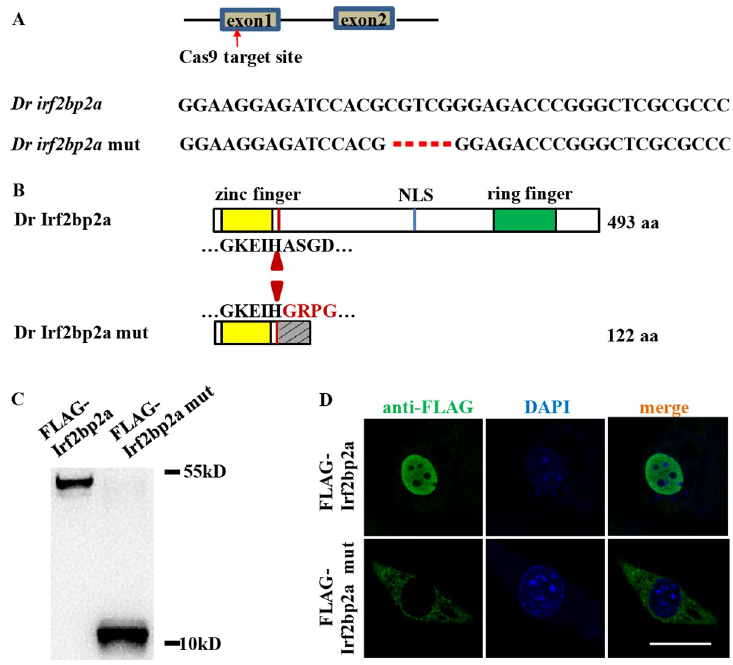
Fig 1. The establishment of a zebrafish irf2bp2a knockout line. (A) Schematic representation of Cas9 target site in the first exon of zebrafish irf2bp2a . The deleted nucleotides in the mutant gene are marked by hyphens. (B) Schematic representation of wild type (493 amino acids) and mutant Irf2bp2a proteins (122 amino acids). The site where the frameshift was introduced is marked by triangles. (C) Western blot analysis of FLAG-tagged wild type and mutant Irf2bp2a proteins expressed in HEK293 cells. (D) Immunofluorescence analysis of FLAG-tagged wild type (top panel) and mutant Irf2bp2a (bottom panel) proteins, demonstrating that the truncated protein lost its nuclear localization. Scale bar, 10 μ